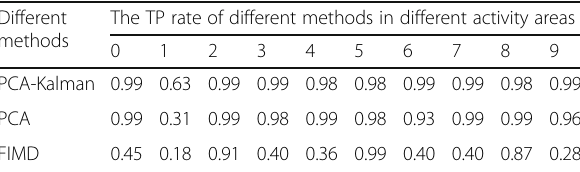
Table 5 The TP rate of different methods in different activity areas Different The TP rate of different methods in different activity areas methods 0